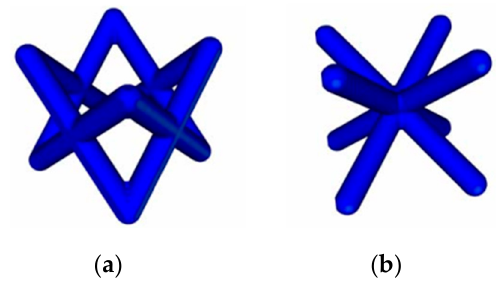
Figure A1. ( a ) Octet-truss [24]; ( b ) Kagomé [142].